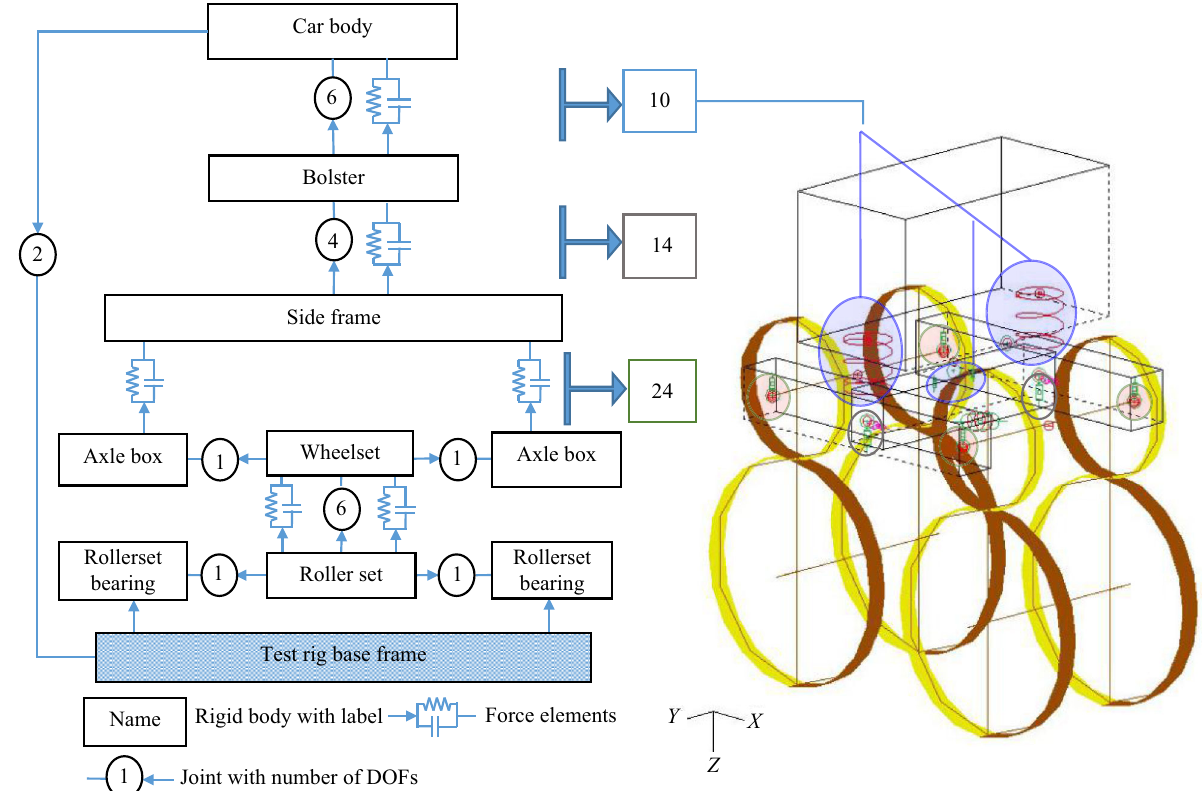
Fig. 4 Bogie test rig model with mass, force element, constraints, and joint with the degree of freedom. Adopted from